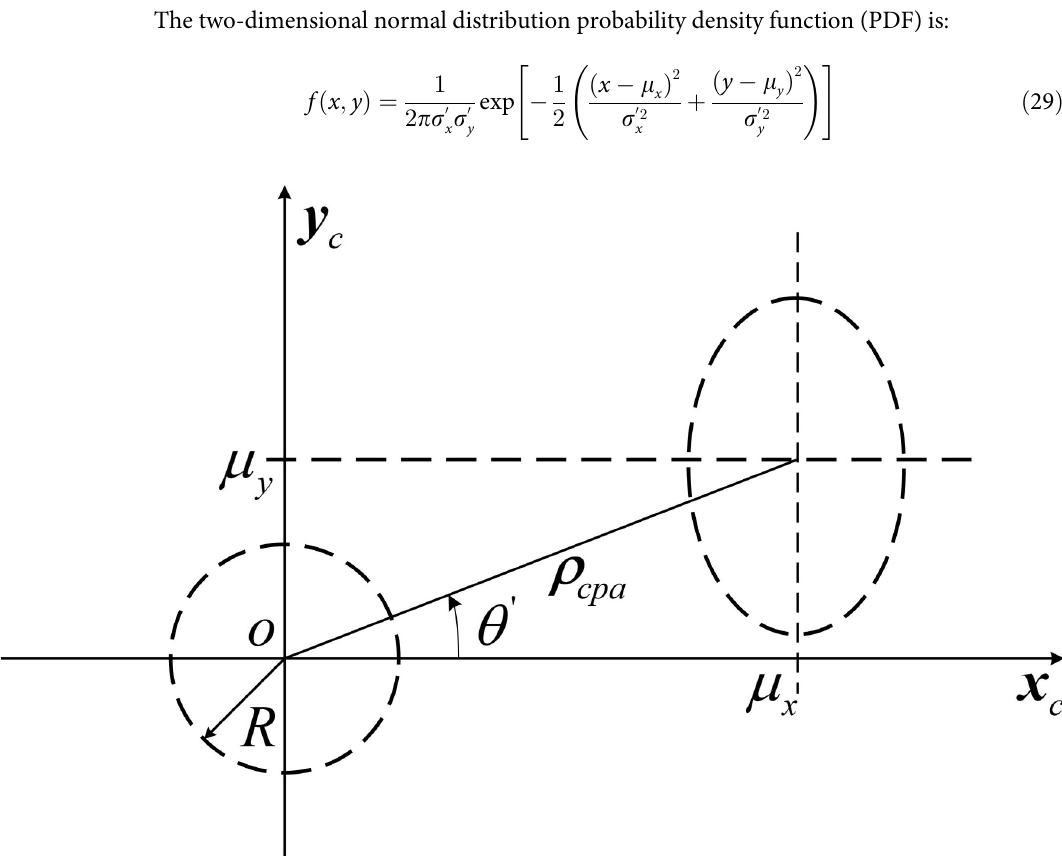
Fig 8. Integral calculation coordinate